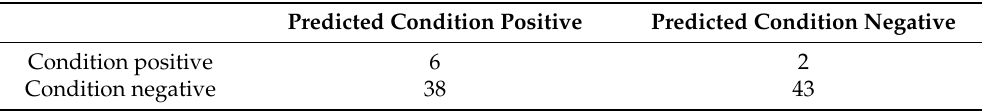
Table 2. Evaluation of gas sensor